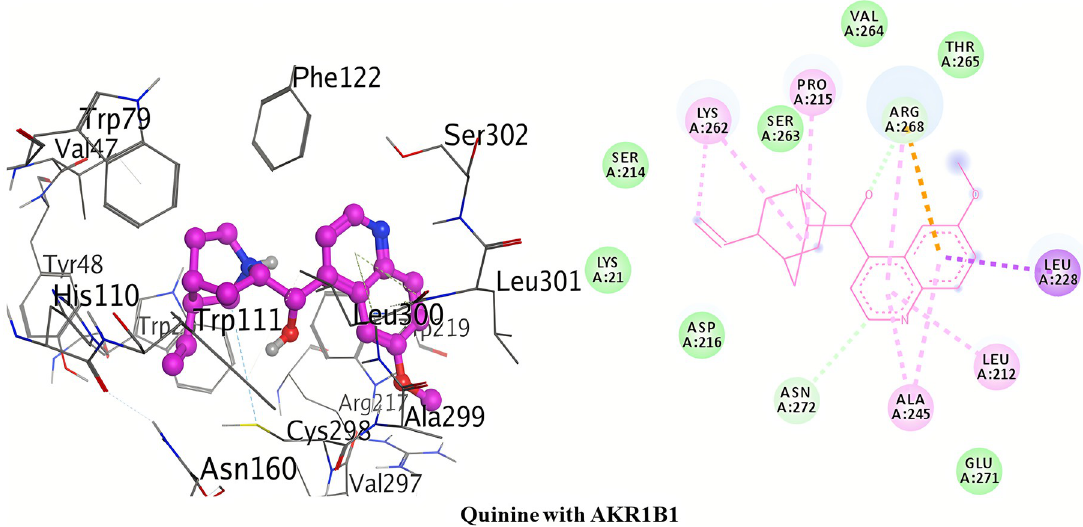
Fig 6. 3D and 2D interactions of quinine with active site of